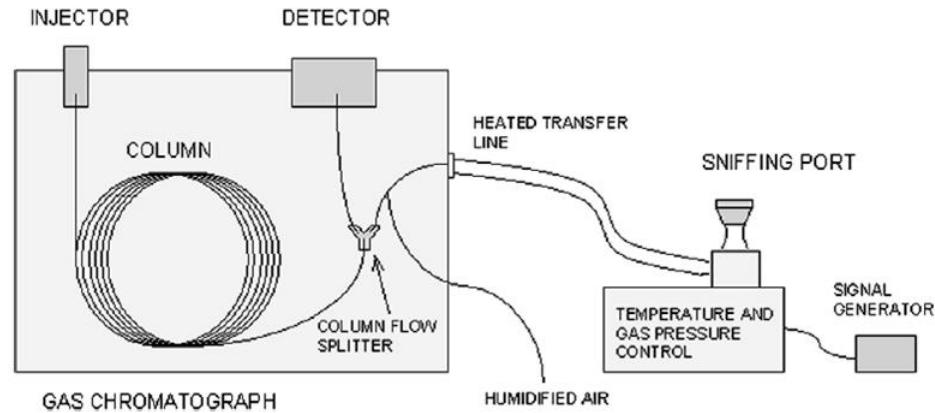
Figure 1. Scheme of the gas chromatograph equipped with an olfactometric detector (reprinted from [22] with permission from